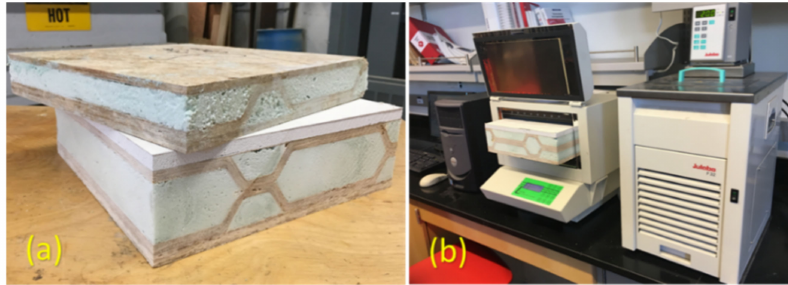
Figure 6. Thermal test ( a ) samples of both sandwich panels ( b ) heat flow